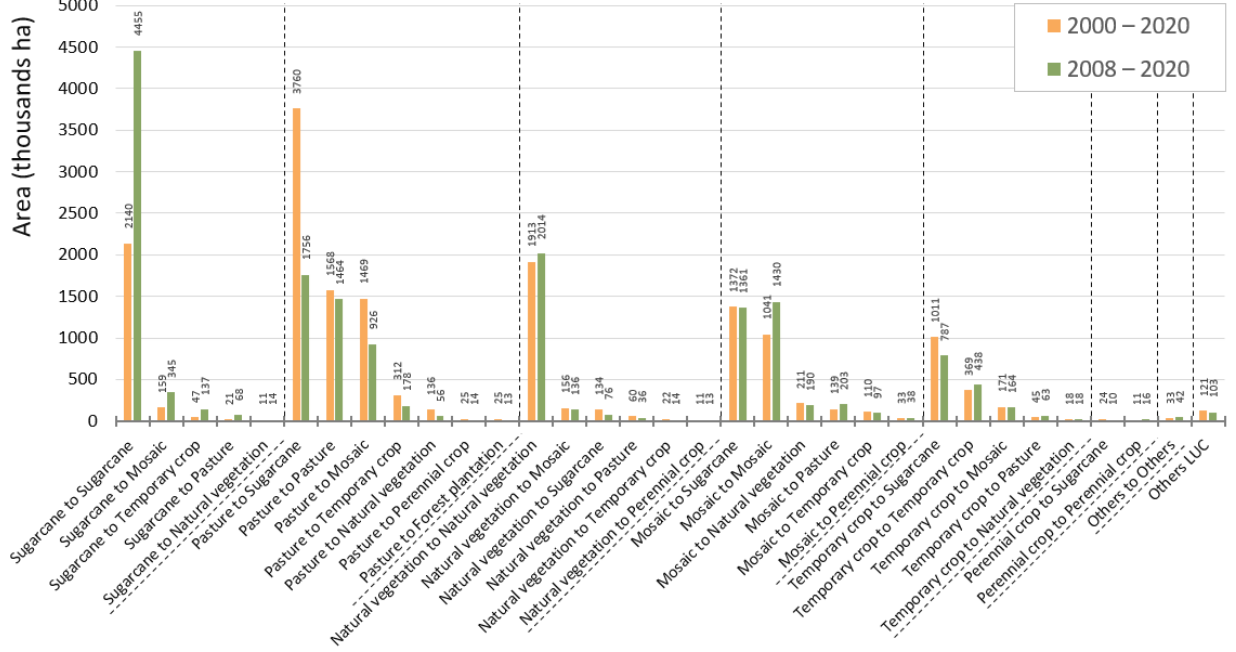
Figure 4. LUCs observed within the whole CARs area with sugarcane cultivation, in Brazil’s center– south and north regions, during the 2000–2020 and 2008–2020 periods. All detailed LUCs are presented in Supplementary Material S1.